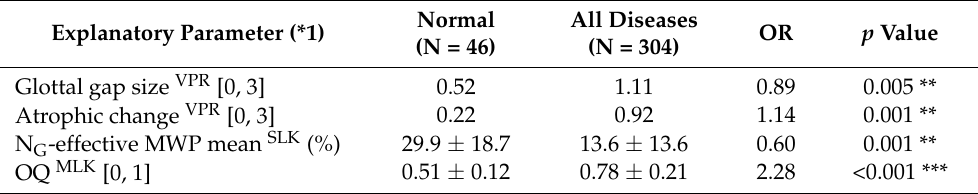
Table 7. Key parameters of all laryngeal disorders. Explanatory Parameter